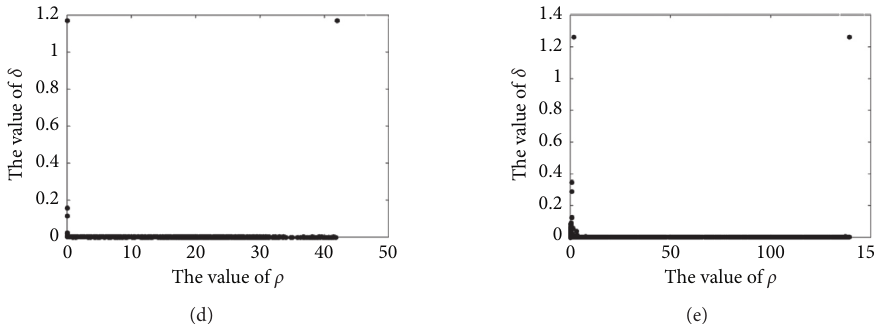
Figure 16: Result of local density ρ i and the distance δ i by using the SDAE-CFS for bearings 11–15. (a) SDAE-CFS-bearing 11. (b) SDAE- CFS-bearing 12. (c) SDAE-CFS-bearing 13. (d) SDAE-CFS-bearing 14. (e) SDAE-CFS-bearing 15.